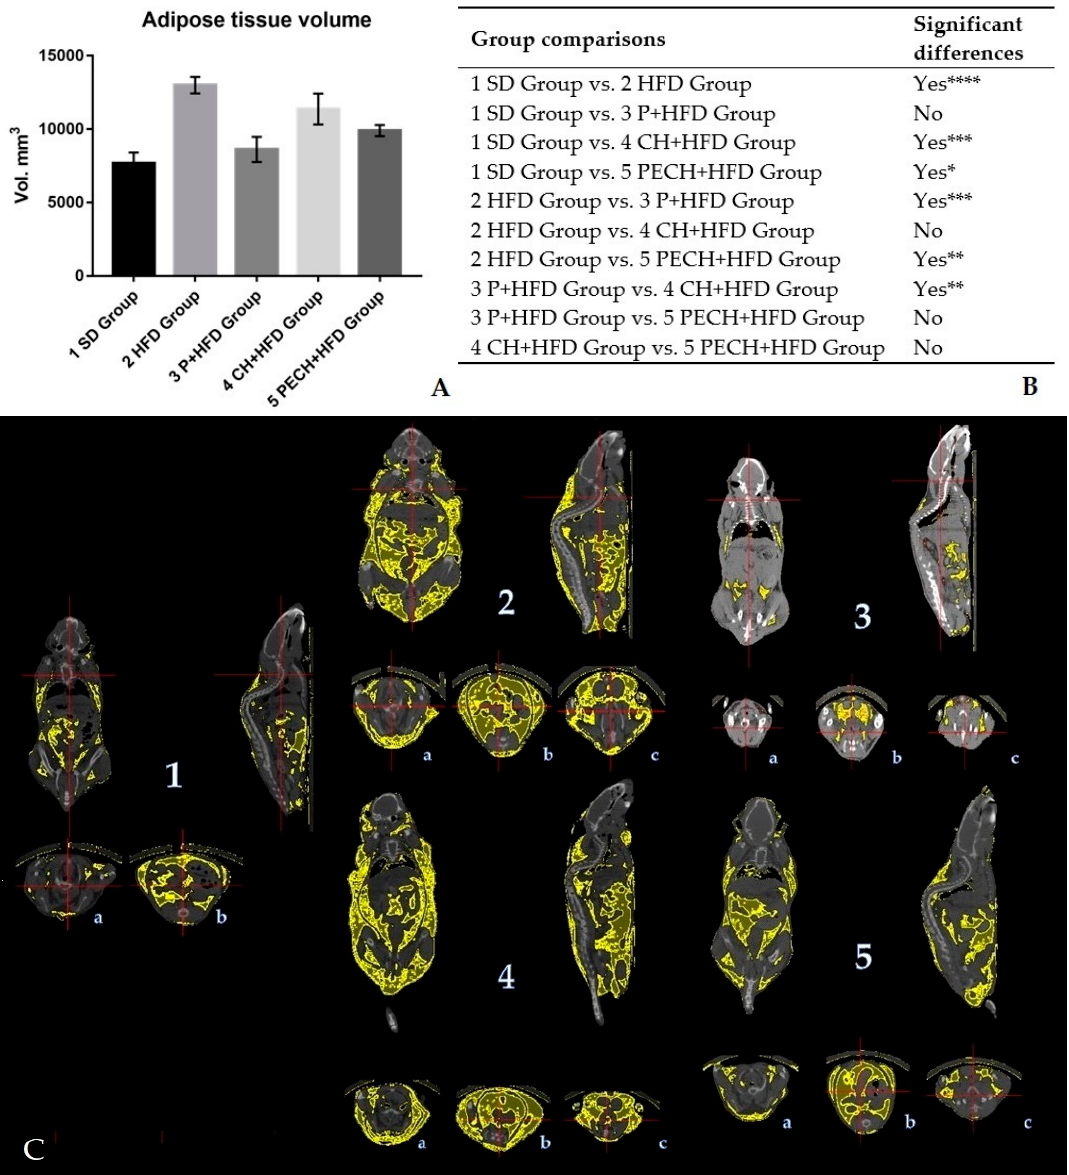
Figure 1. Effect of the different diets on the adipose tissue volume. ( A ) Adipose tissue volume expressed as mm 3 at the end of the study. Numbers and groups correspond as following: (1) Standard diet, (SD), (2) high-fat diet (HFD), (3) phenolic-enriched high-fat diet (P+HFD), (4) lyophilized cooked ham enriched high-fat diet (CH+HFD) and (5) lyophilized phenolic enriched cooked ham enriched high-fat diet (PECH). ( B ) Statistical comparison Significant differences are expressed as * p < 0.05 ** p < 0.01 *** p < 0.001 **** p < 0.0001 ( C ) PET / SPECT / CT computerized images showing areas with a density attributed to adipose tissue coloured by yellow (voxels).